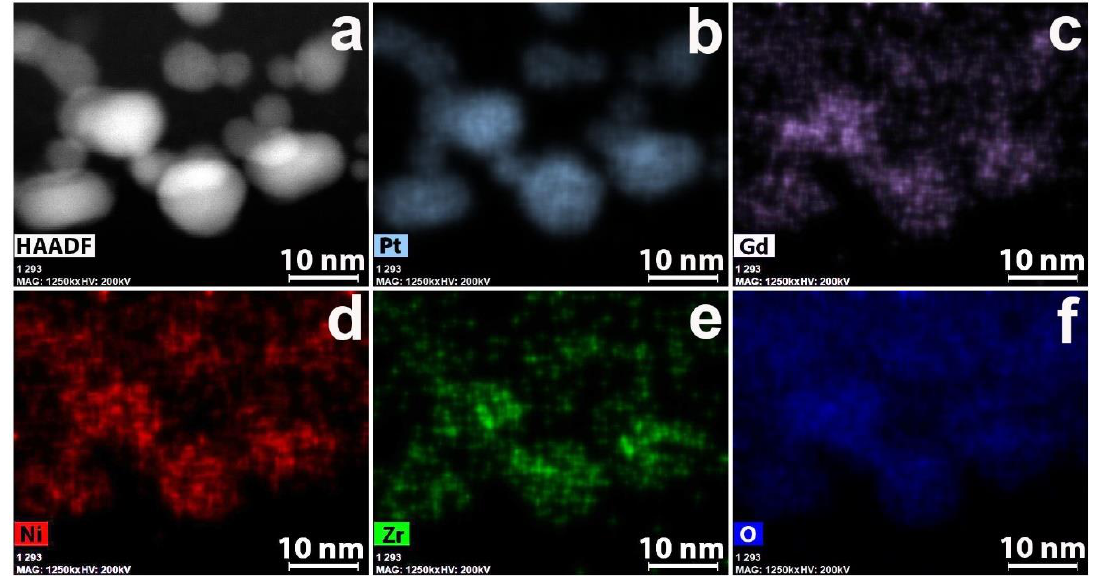
Figure 11. ( a ) HAADF STEM, and EDX distribution maps for ( b ) Pt, ( c ) Gd, ( d ) Ni, ( e ) Zr and ( f ) O for Figure 11. (a) HAADF STEM, and EDX distribution maps for (b) Pt, (c) Gd, (d) Ni, (e) Zr and (f) O for Pt / 1’ after working in membrane-electrode Pt/1’ after working in membrane-electrode assembly.